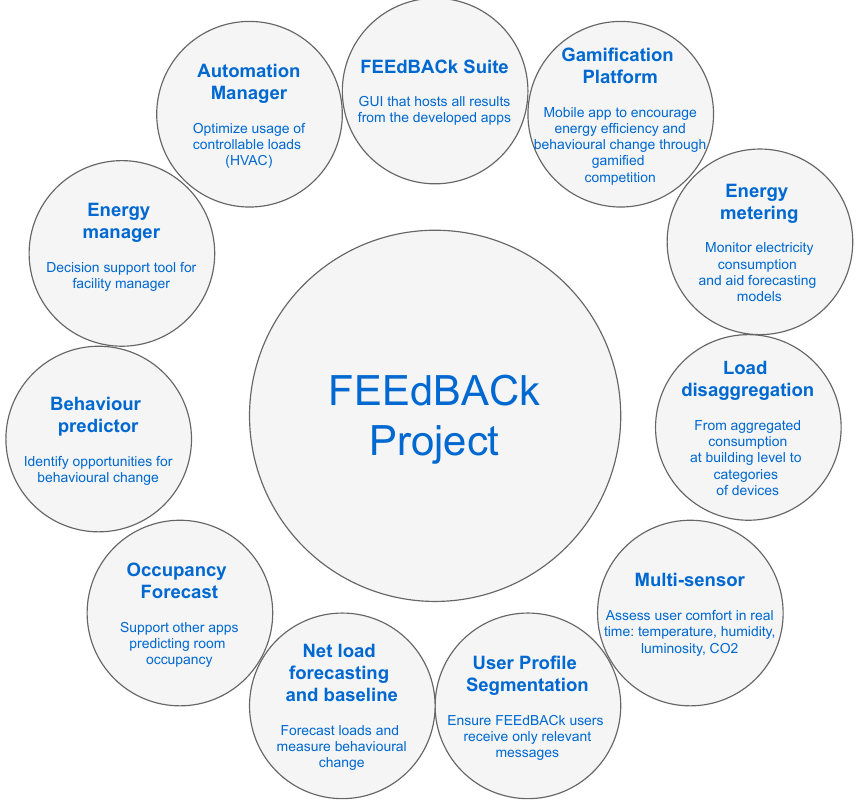
Figure 1. FEEdBACk suite integration block-scheme in a FEEdBACk ICT-based